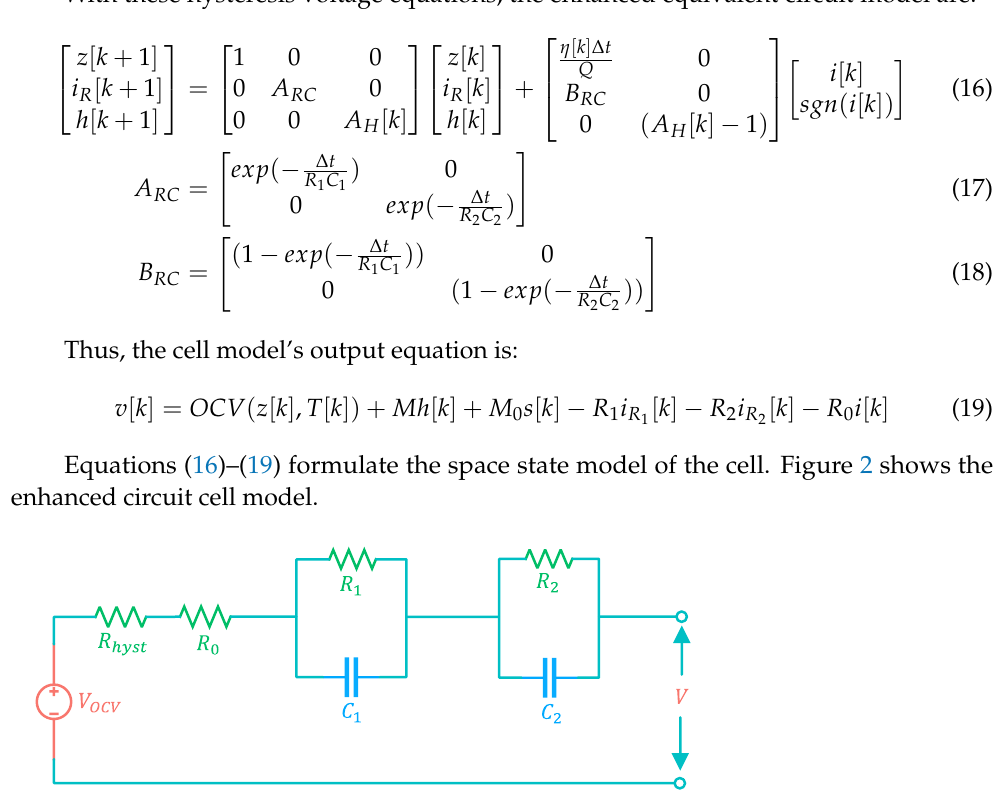
Figure 2. Enhanced circuit cell